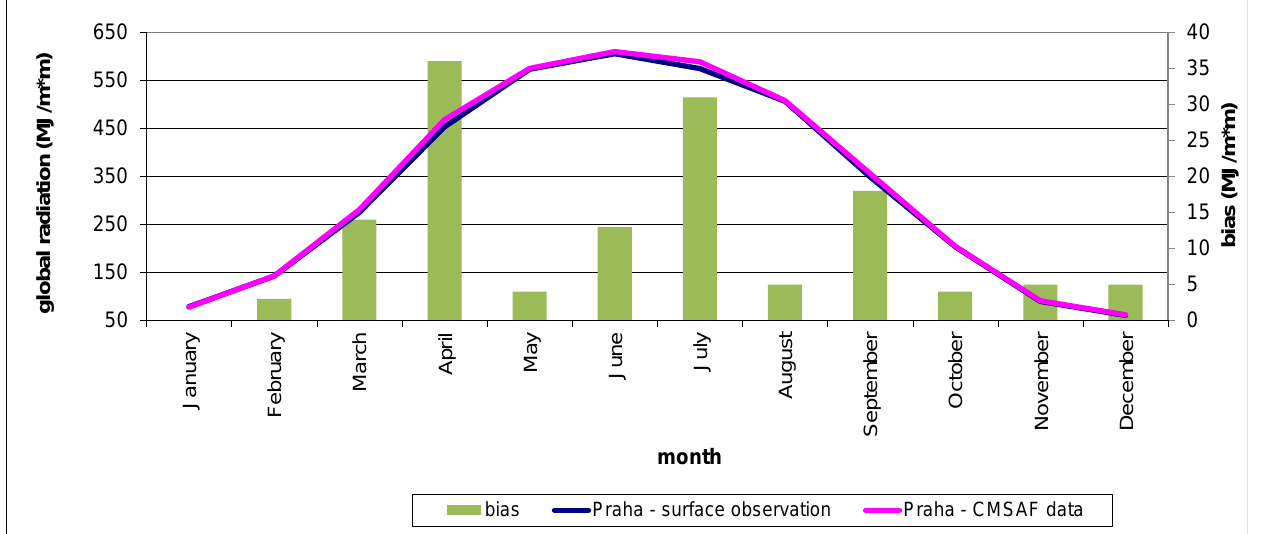
Figure 2. Average annual course (1989–2009) of average monthly sums of SIS radiation (MJ = mega-joules, m = metre) for Prague both for the surface station-and satellite-derived data (SIS product of CMSAF); the bias is also